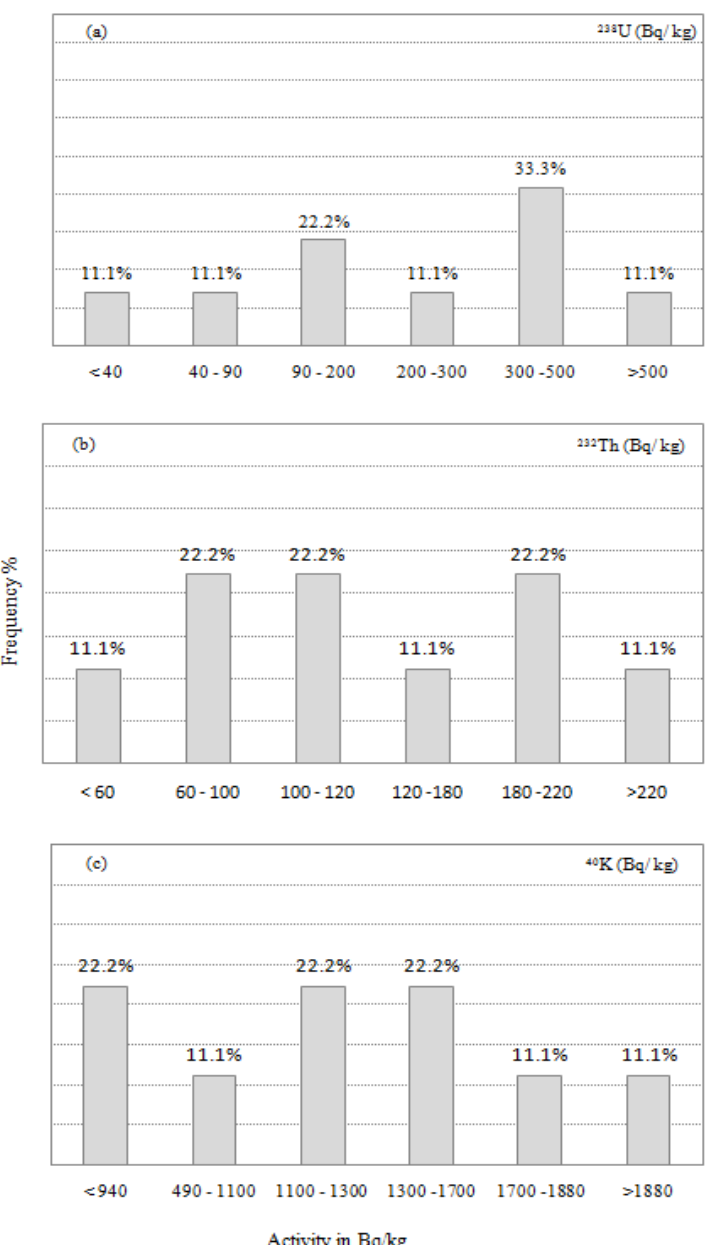
Figure 5. Frequency distribution of activity concentrations (Bq kg − 1 ) for the Sol Hamed bostonite dykes: ( a ) 238 U; ( b ) 232 Th; ( c ) 40 K.